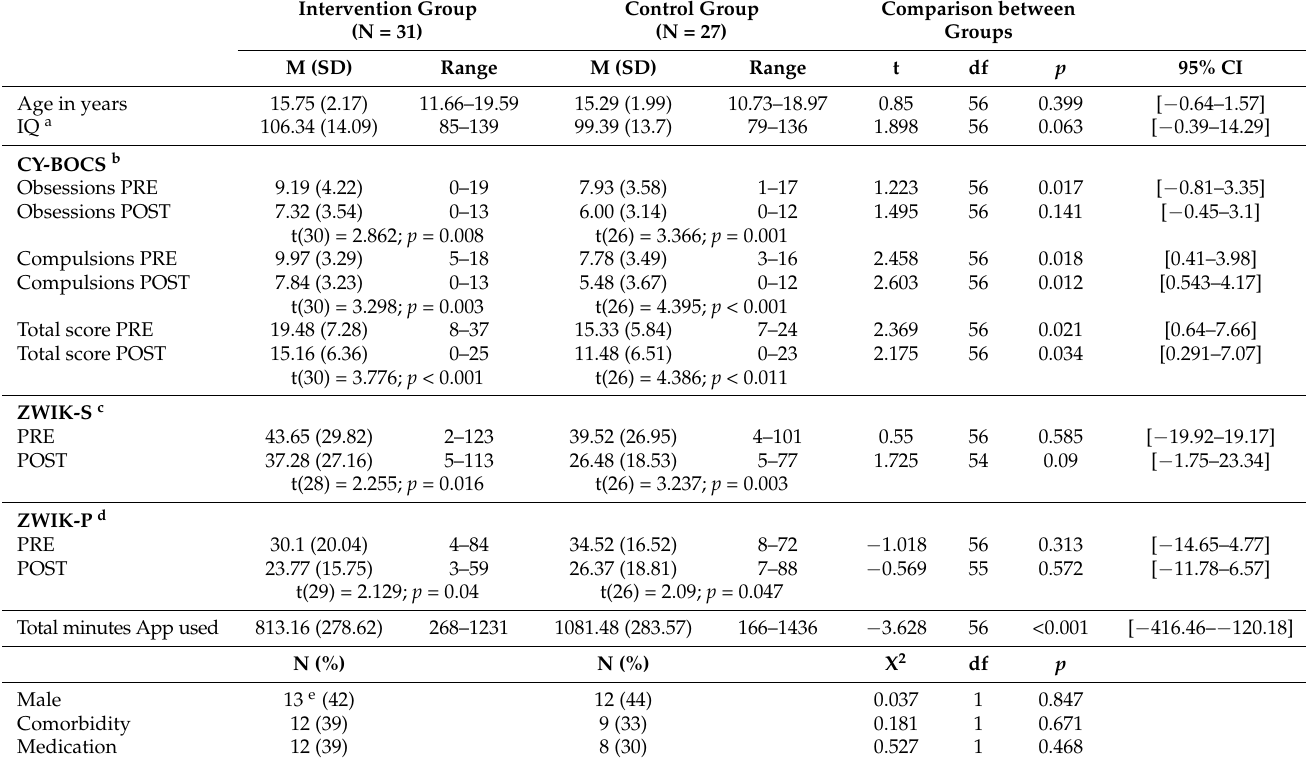
Table 1. Demographics and clinical characteristics of the final sample (N =